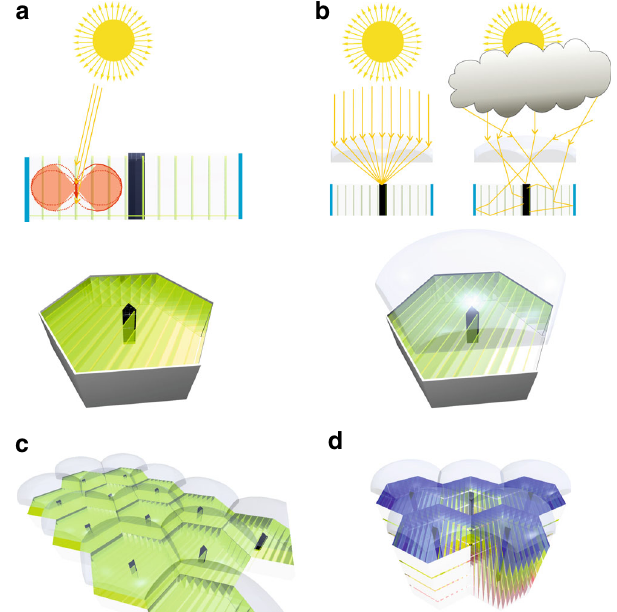
Fig. 4 Potential photoprotective concentrator architectures. The lea fl